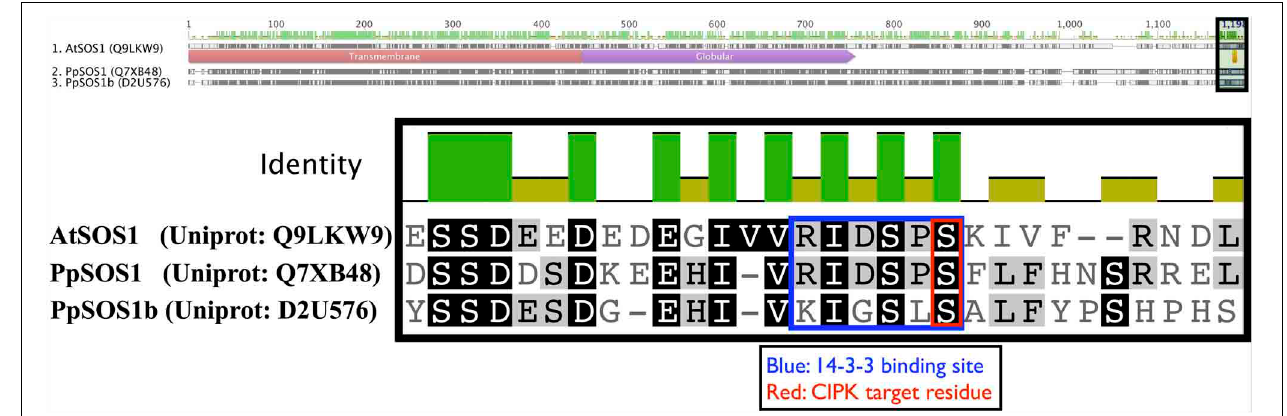
FIGURE 10 | Key regulatory residuesatthe C-terminusofArabidopsis SOS1(AtSOS1)areconserved in Physcomitrella homologs. The full-length protein sequence alignment isshown on top withthe zoomed inregion indicated by ashaded box. Arabidopsis CIPK24 (SOS2) phosphorylates the